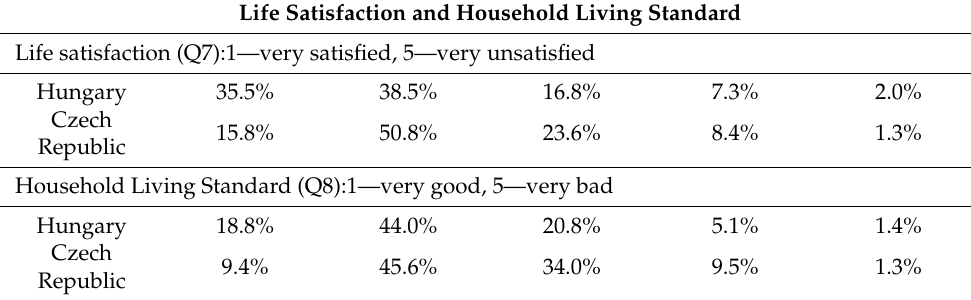
Table 2. Compared results for Q7 andQ8 [5]. Life Satisfaction and Household Living